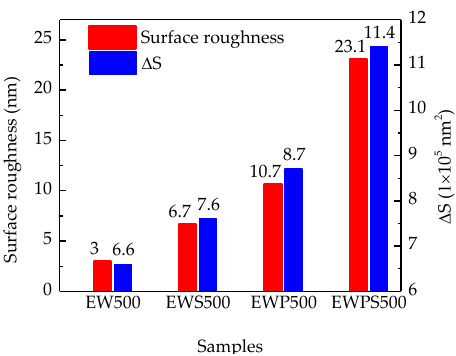
Figure 7. The surface roughness and increased surface area (∆ S , compared with their projected area: 10,000 nm × 10,000 nm) of EW500, EWS500, EWP500, and EWPS500, which were determined from the corresponding AFM images by the AFM support software.